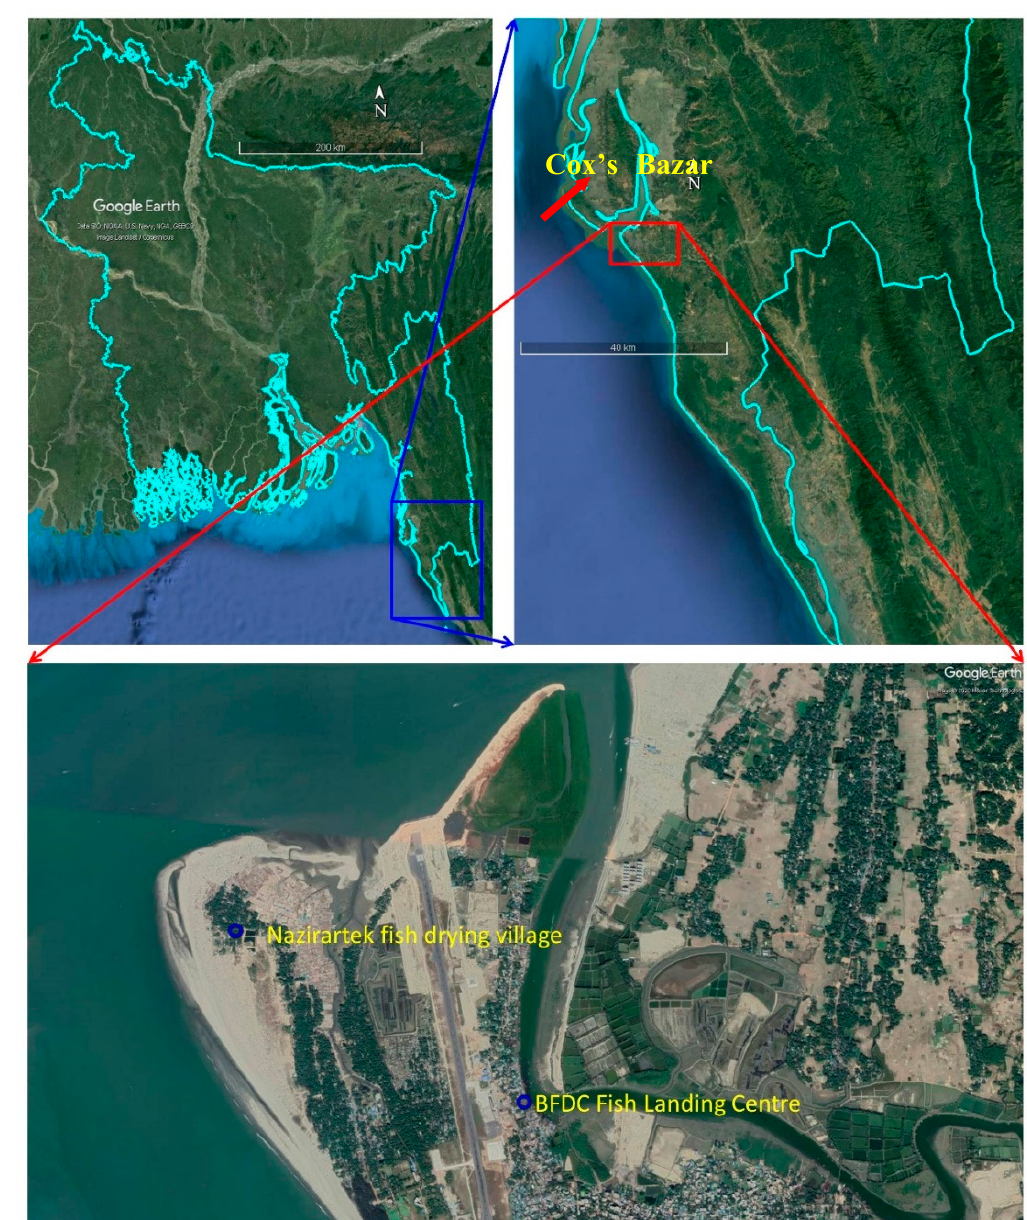
Figure 1. Location of the study area in Cox’s Bazar district of Bangladesh (Google Maps).